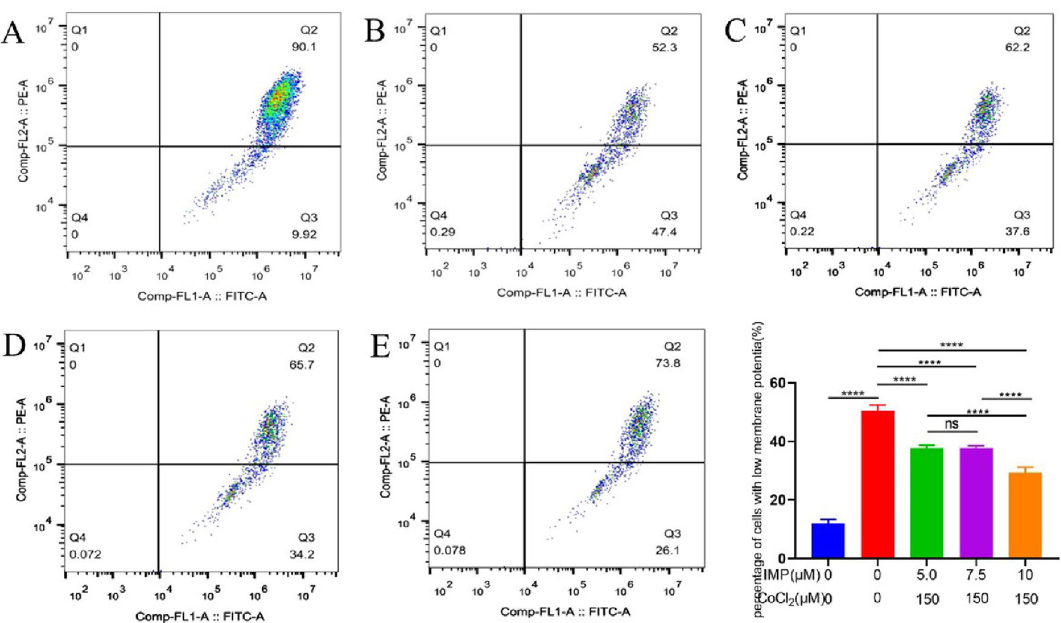
Figure 5. The effect of IMP on the mitochondrial membrane potential of CoCl2-induced hypoxia in hippocampal neuronal cells. The Q2 quadrant in the figure is the polymer of JC-10, which is expressed as red fluorescence. When the mitochondrial membrane potential drops, the Q3 quadrant of JC-10 decomposed into monomers and expressed as green fluorescence. ( A ) Normal group, ( B ) CoCl2 treatment group, ( C ) CoCl2 + 5.0 μmol/l IMP, ( D ) CoCl2 + 7.5 μmol/l IMP, ( E ) CoCl2 + 10.0 μmol/l IMP. (n = 6 for every group; ns, there was no statistical difference; **** P <